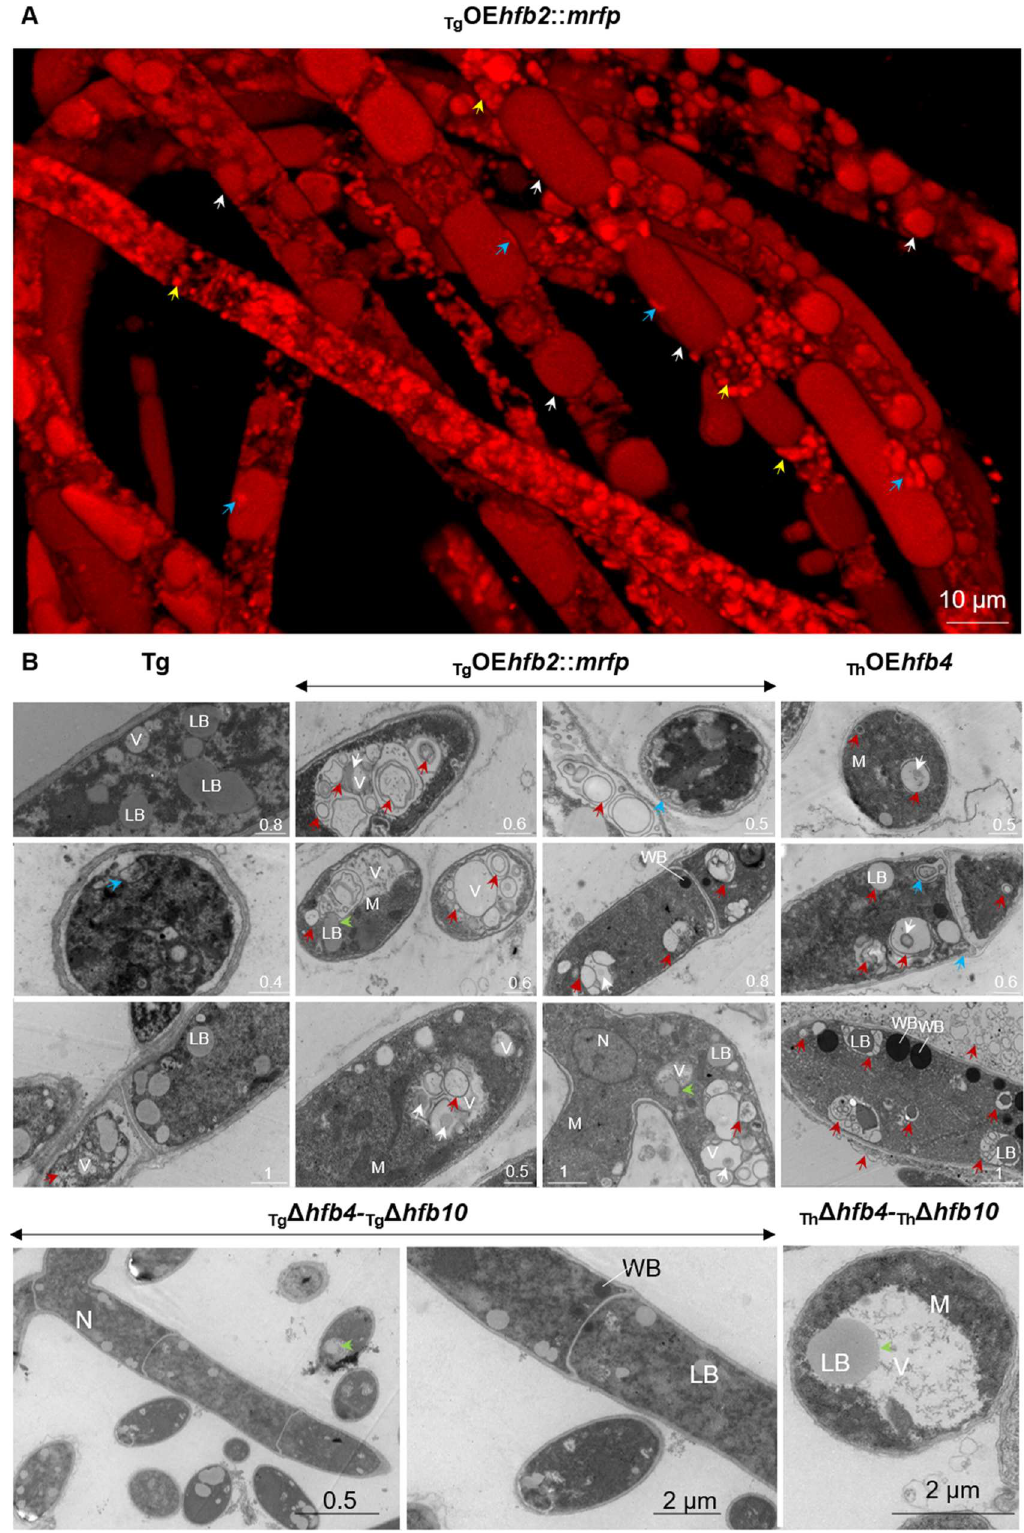
Fig 3. Ultrastructure of Trichoderma hyphae enriched in HFBs. (A) Aerial hyphae of T . guizhouense producing HFB2::mRFP under the control of the strong constitutive promoter of the cdna1 gene from T . reesei QM6a (See Materials and Methods